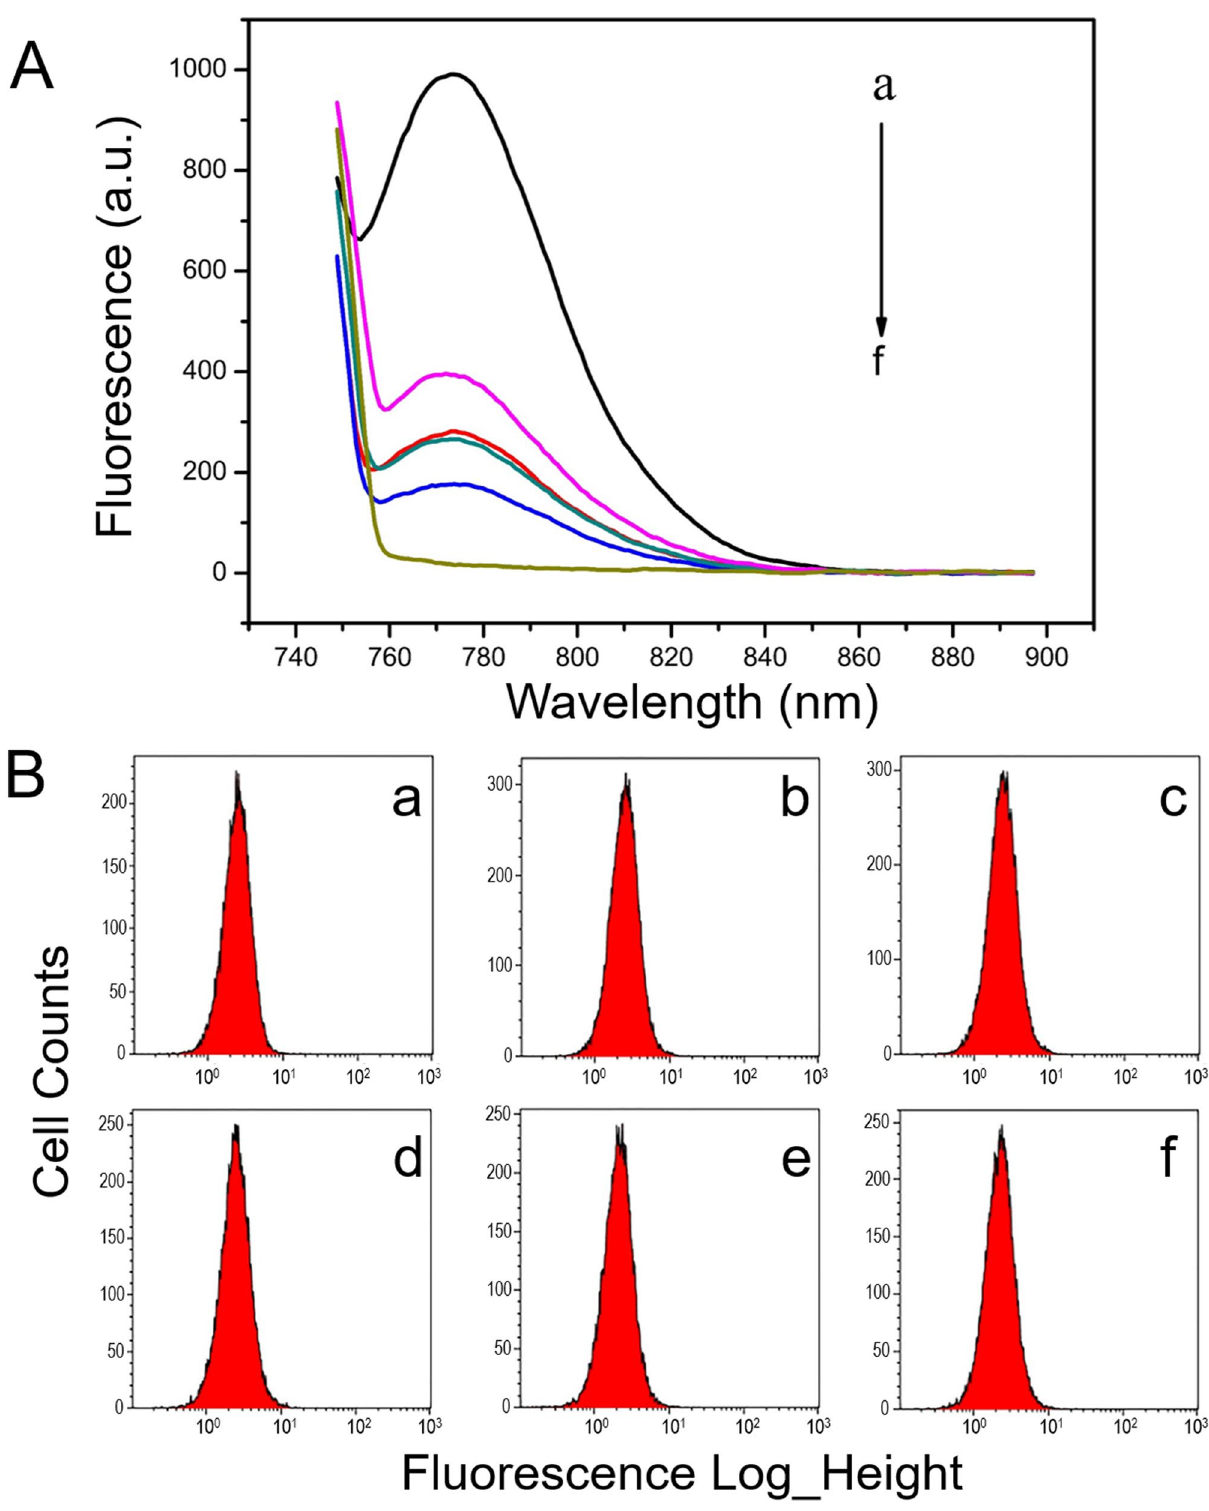
Figure 5. Fluorescence quenching effect of NGO. ( A ) The NGO extinction efficacy of fluorescence was measured with fluorescence spectrophotometer. The fluorescence intensity of AF750-6Ahx-Sta-BBN decreases with increase of concentrations of NGO (a–f: for 0, 0.01, 0.02, 0.04, 0.08, 0.1 mg/mL, respectively). ( B ) Fluorescence recovery of the probes formed by NGO after incubation with HSC-3 for 40 min; (a–f) histogram of HSC-3 cell counts for the probes at the concentration of NGO: 0, 0.01, 0.02, 0.04, 0.08, 0.1 mg/mL,